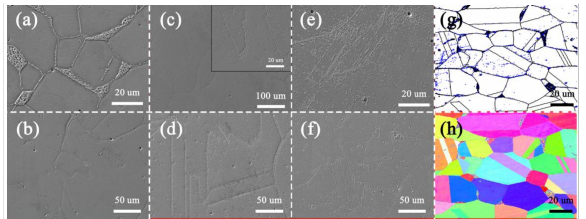
Figure 5. Images of annealed twins in heat-treated novel nitrogen-free austenitic stainless steel samples with the addition of ( a ) 500 ppm, ( b ) 750 ppm, ( c , d ) 1000 ppm, ( e ) 1500 ppm, and ( f ) 2000 ppm graphite; ( g ) OIM diagram of sample B; ( h ) IPF diagram of sample